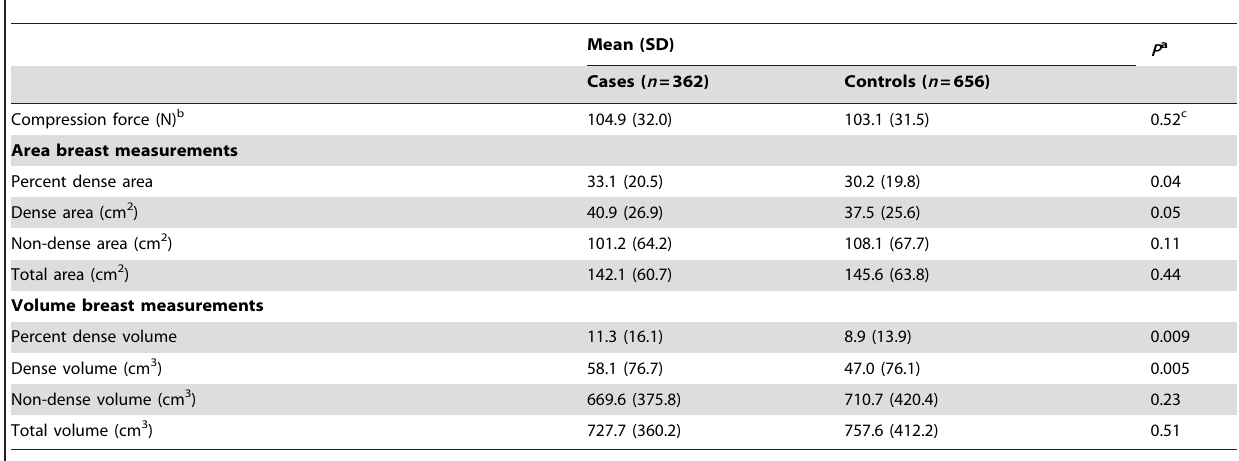
Table 2. Breast measurements by case-control status.